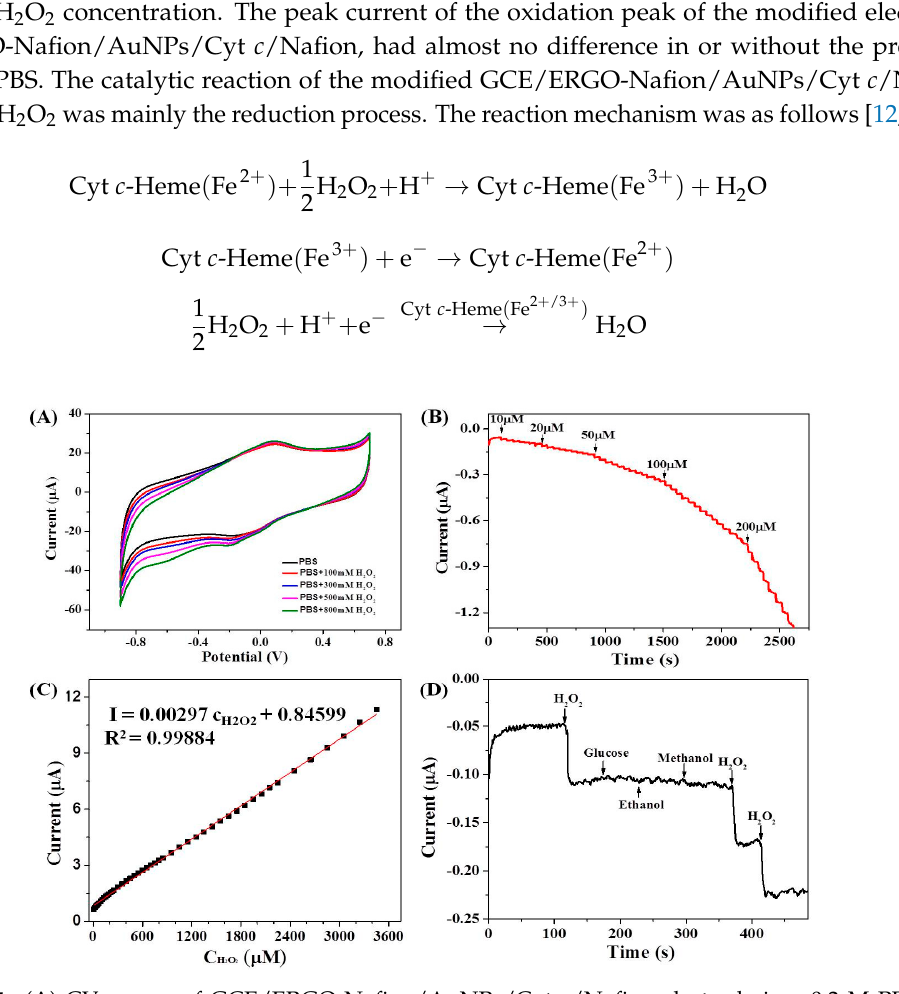
Figure 5. ( A ) CV curves of GCE/ERGO-Nafion/AuNPs/Cyt c /Nafion electrode in a 0.2 M PBS (pH = 7.0) containing varied amounts of H 2 O 2 at a rate of 50 mV/s. ( B ) Typical steady state response of the GCE/ERGO-Nafion/AuNPs/Cyt c /Nafion electrode at an applied potential of − 0.2 V to the successive injection of H 2 O 2 into 0.2 M PBS (pH = 7.4). ( C ) Calibration curve of the linear dependence of the cathodic peak current on the H 2 O 2 concentration. ( D ) Amperometric response of the GCE/ERGO-Nafion/AuNPs/Cyt c /Nafion electrode in a 0.2 M PBS (pH = 7.4) at an applied potential of − 0.2 V to which 100 µ M H 2 O 2 , 100 µ M Glucose, 100 µ M Ethanol, 100 µ M Methanol, 100 µ M H 2 O 2 , and 100 µ M H 2 O 2 were added, respectively.